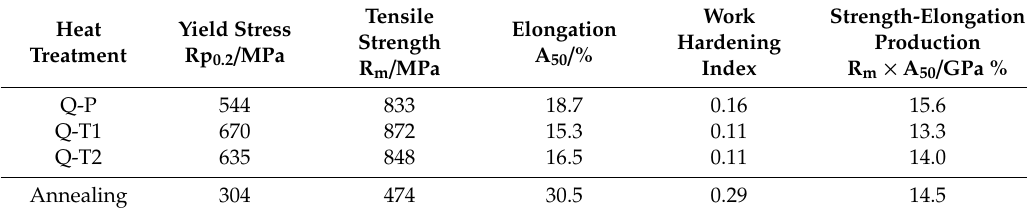
Figure 8. Engineering stress–strain curves of specimens undergoing different treatments. Table 2. Properties of specimens processed through different treatments, with the corresponding uncertainty in parentheses: yield strength (±10 MPa), tensile strength (±5 MPa), elongation (±0.5 %), and work hardness index (±0.05).